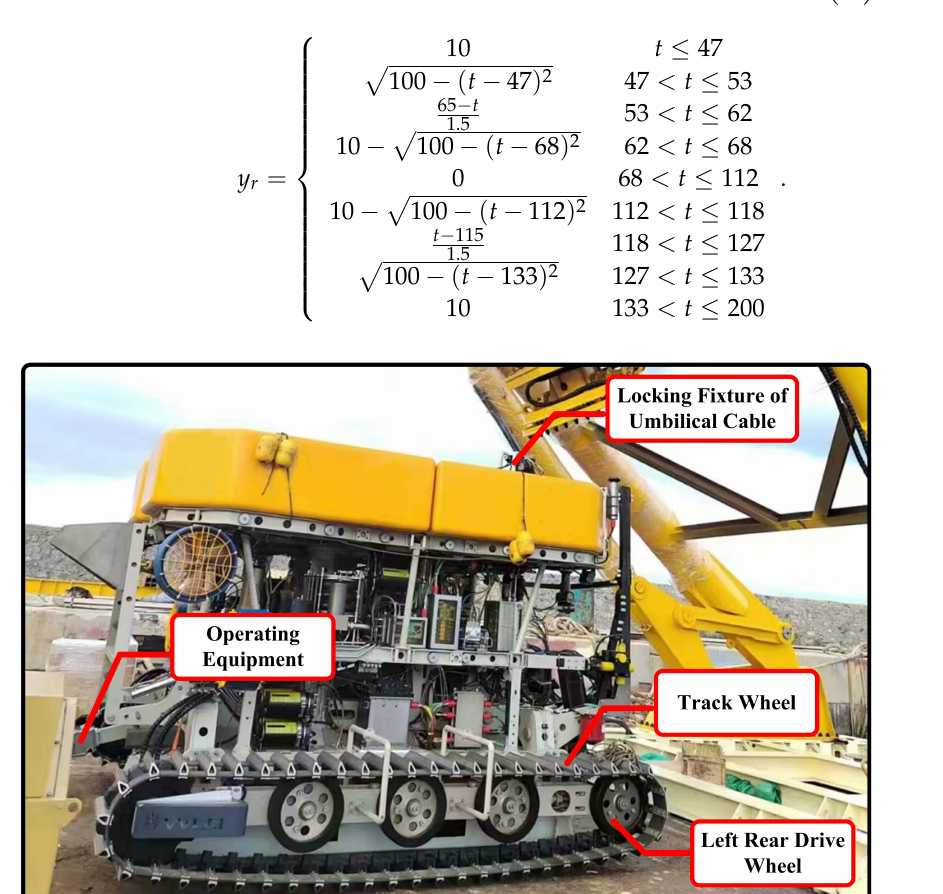
Figure 6. Diagram of the experimentally engineering prototype of